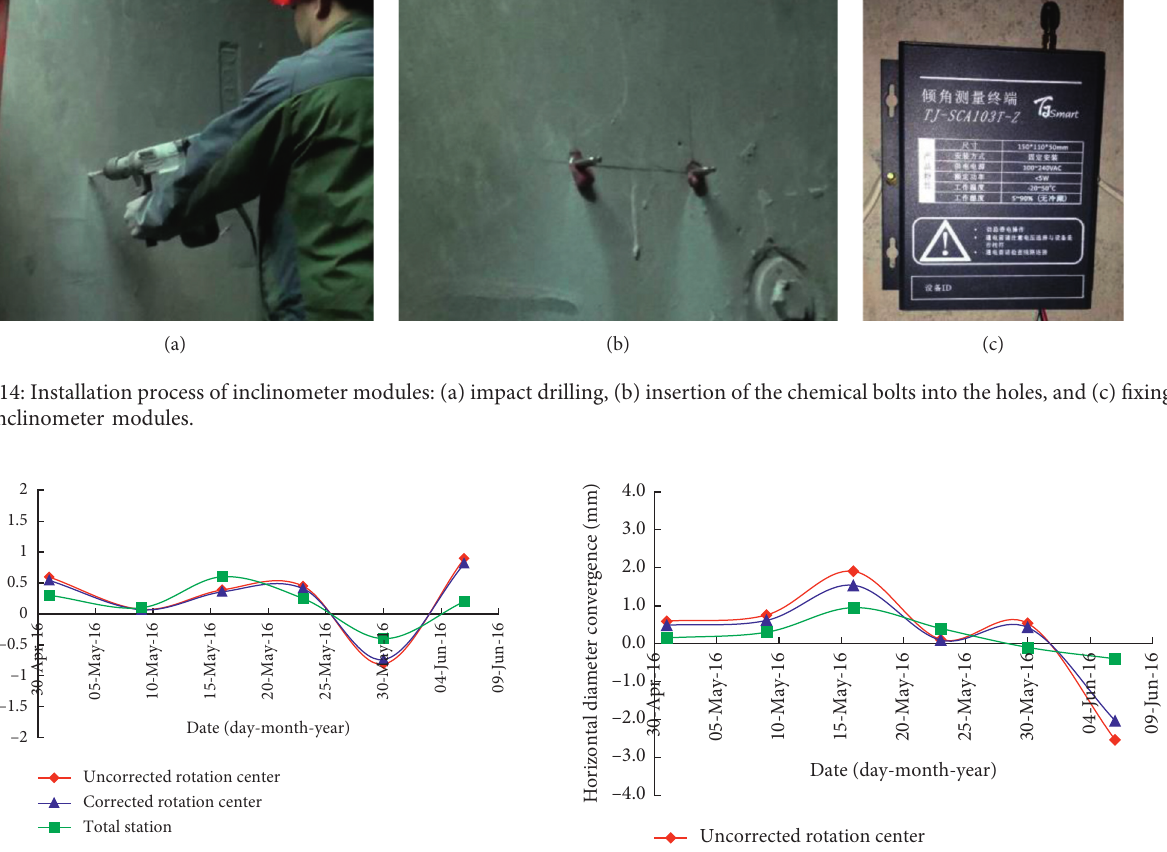
Figure 15: Variation of the tunnel’s horizontal diameter for Ring No. 257.